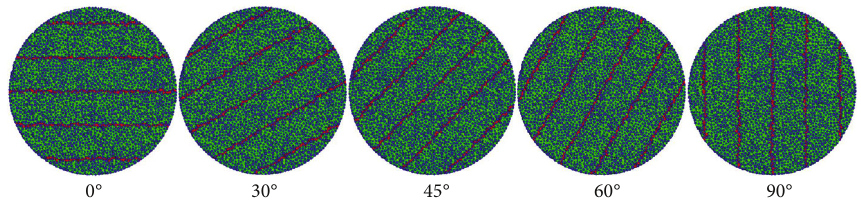
Figure 5: Physical model of Brazilian splitting of layered slate under di ff erent bedding inclination